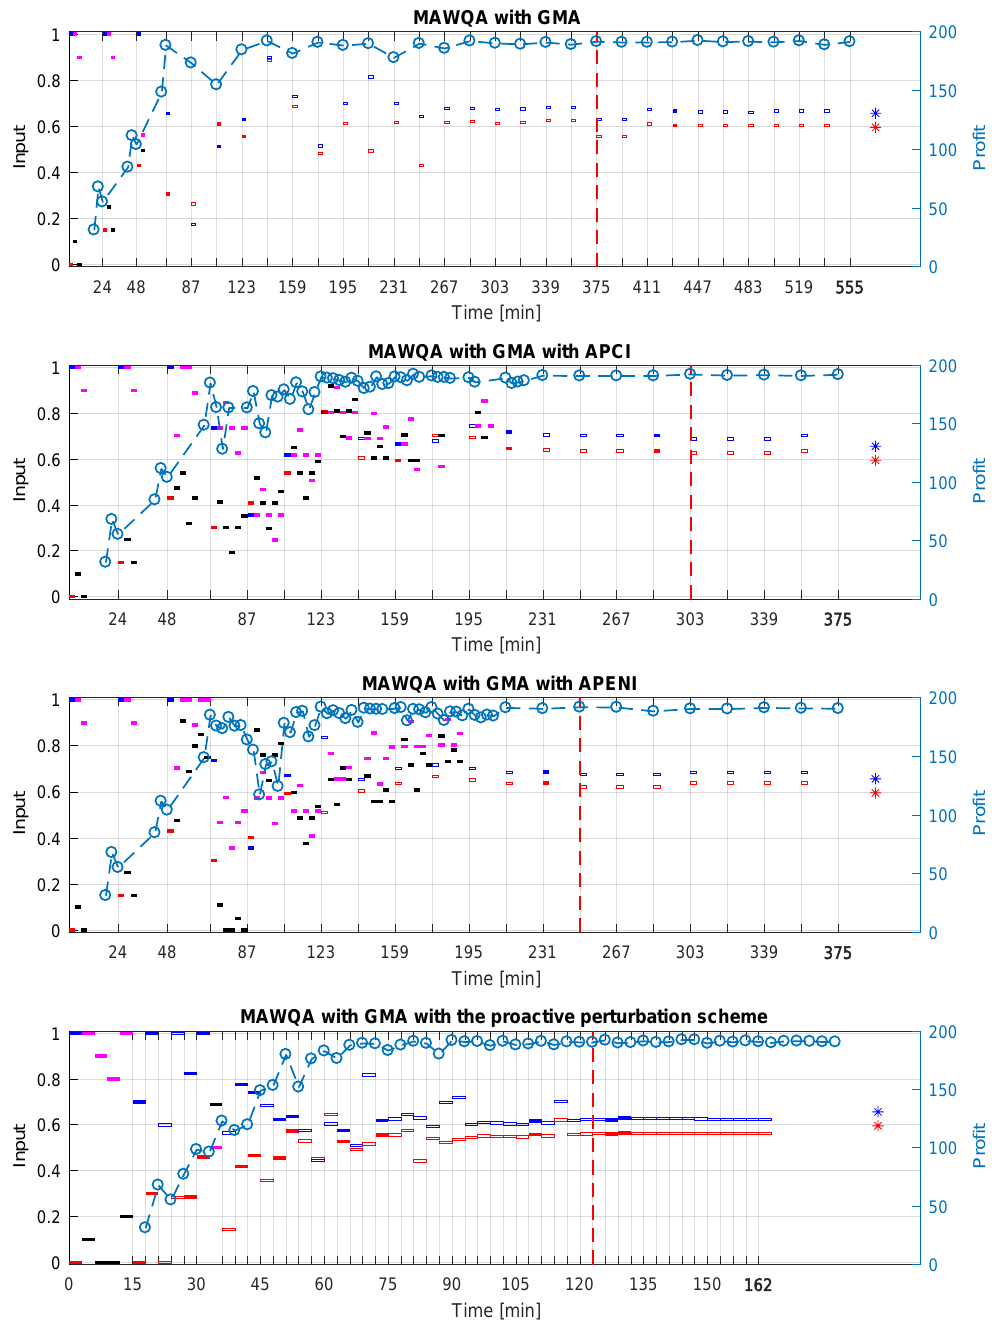
Figure 7. Williams–Otto reactor case study: evolution of the plant profit function and the inputs from MAWQA with GMA with different active perturbation schemes. The vertical red-dashed line repre- sents the time of convergence. Note that the time axis is scaled differently in the different